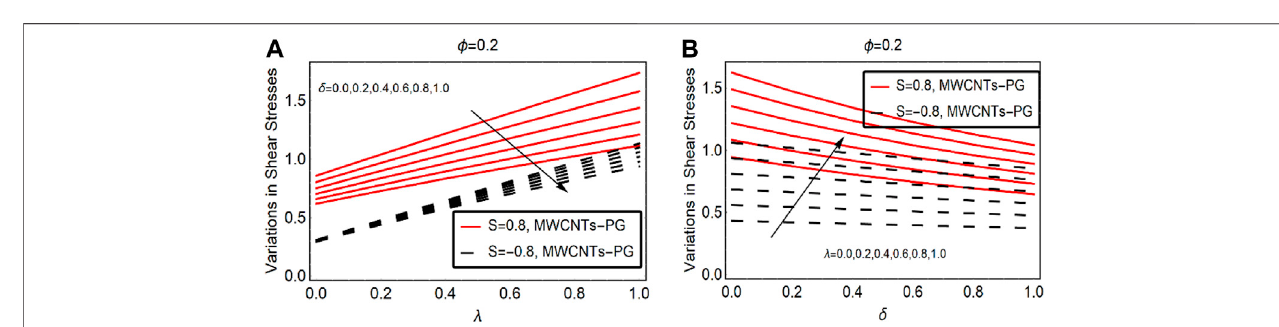
FIGURE 8 | The shear stresses against (A) δ and (B) λ .